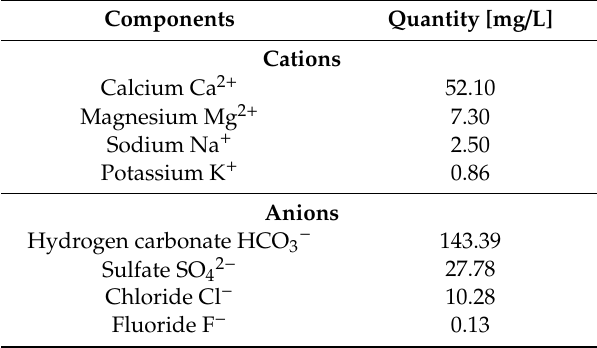
Table 6. Dissolved mineral component content in spring water (Gardinia Aleksandria Company, Domaslaw,